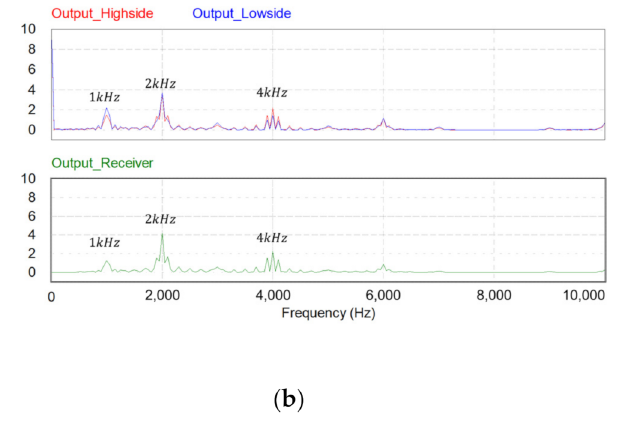
Figure 17. Transmitter/receiver response characteristics (normal state): ( a ) transmitter/receiver frequency response; ( b ) transmitter/receiver FFT characteristics.